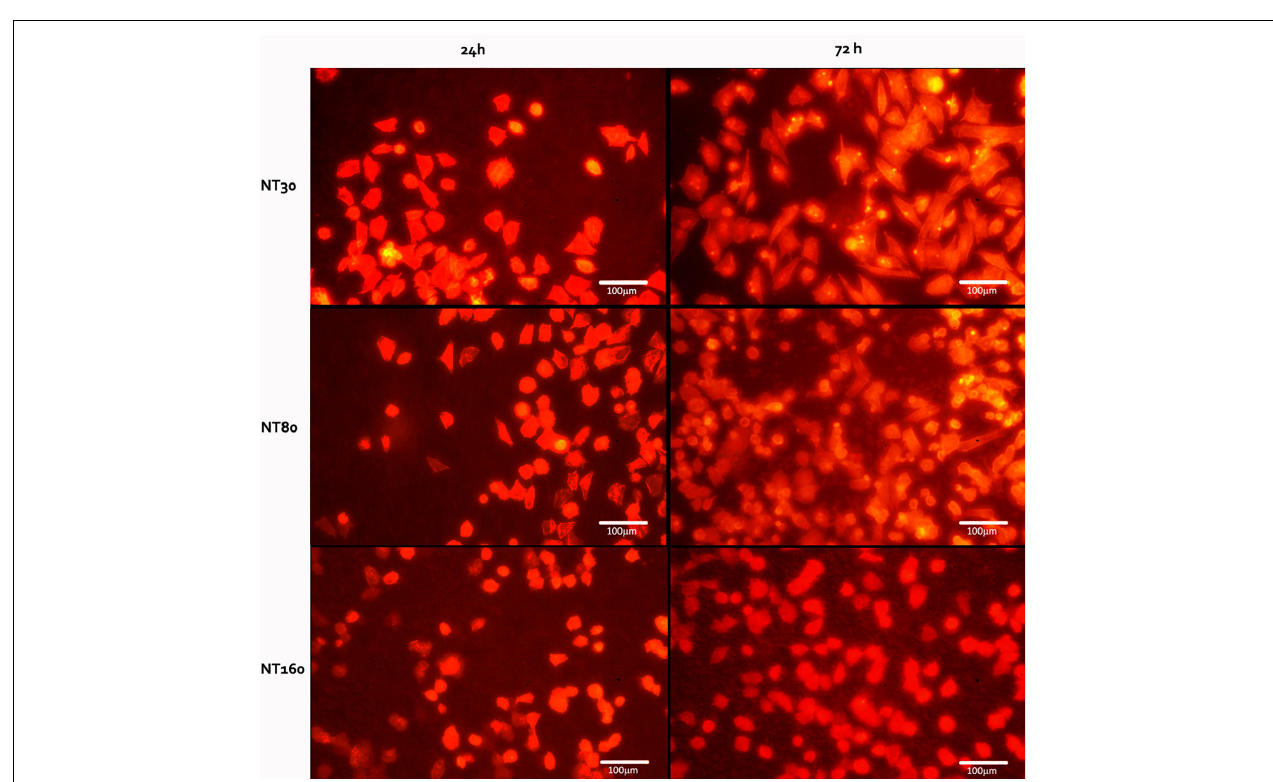
FIGURE 8 | Representative images of the Saos 2 cells on the nanotube samples (NT30, NT80, and NT160) after 24 and 72 h.